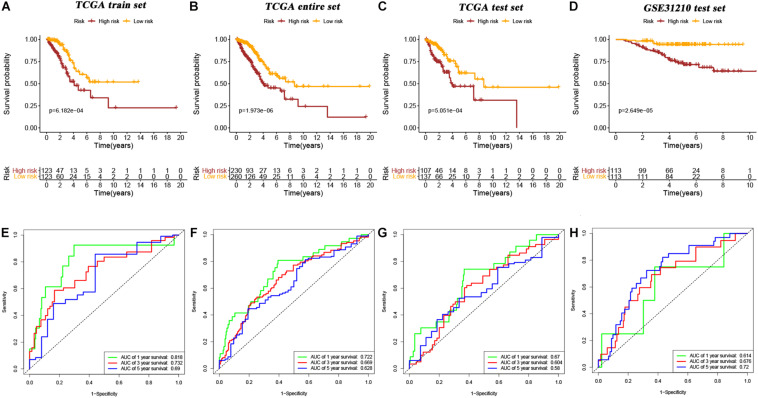
Kaplan–Meier survival curves of OS in high-risk patients vs low-risk patients based on TCGA train set (A), TCGA entire set (B), TCGA test set (C), and GSE31210 test set (D). The ROC curves of the signature for predicting OS in the TCGA train set (E), TCGA entire set (F), TCGA test set (G), and GSE31210 test set (H).